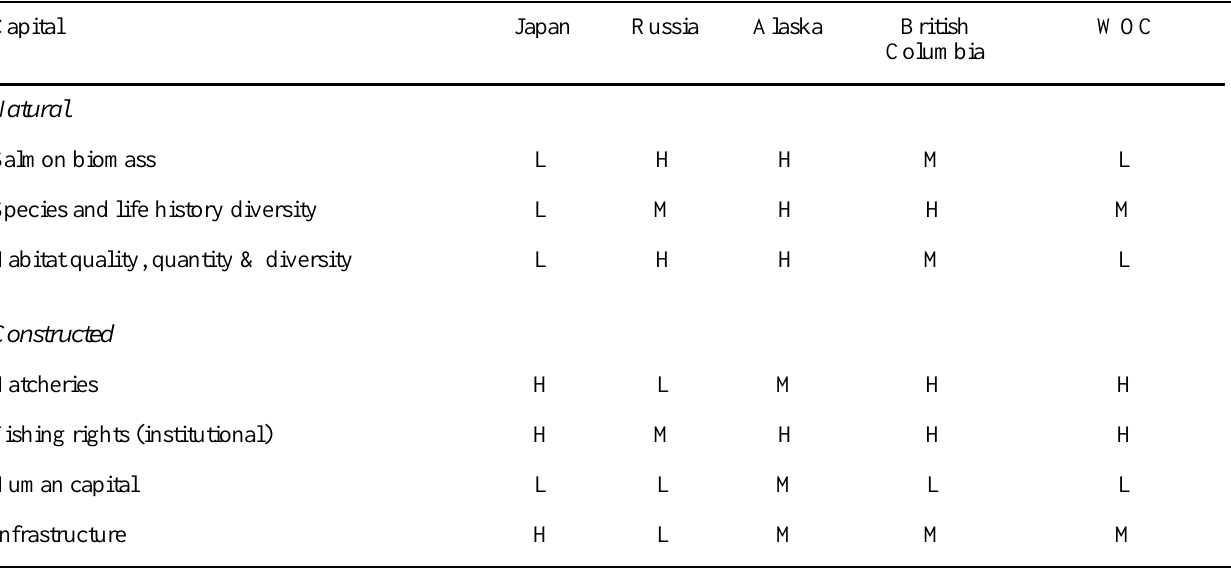
Table 2. Capital rankings for the five salmon fishing regions. H is for high rankings, M is medium, and L is